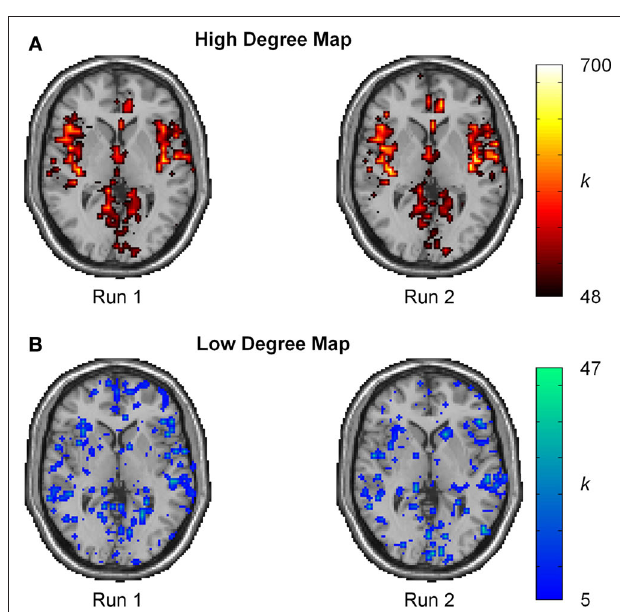
FIguRe 6 | Degree maps for single subject. (A) Spatial localization of high degree nodes ( K ≥ 48) appears to be highly reproducible. (B) Spatial localization for low degree nodes ( K < 48) shows high spatial variation. The high variability and large proportion of low degree nodes results in a low ICC